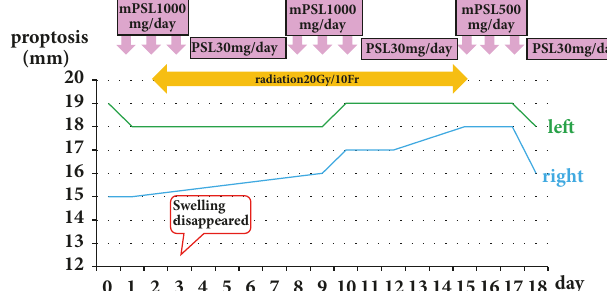
Figure 2: Clinical course of the patient. The patient was hospitalized and received intravenous and oral corticosteroid therapy in conjunction with orbital radiotherapy. Intravenous methylprednisolone 1000mg/day for 3 days followed by oral prednisolone 30mg/day for 4 days were defined as one cycle, and he received 3 cycles consecutively with a slightly decreased methylprednisolone i.v. in the third cycle. Orbital radiation therapy was commenced on day 2 and 2Gy/day radiation was continued for 10 days (20Gy total). The patient was discharged on oral corticosteroid therapy with decreasing